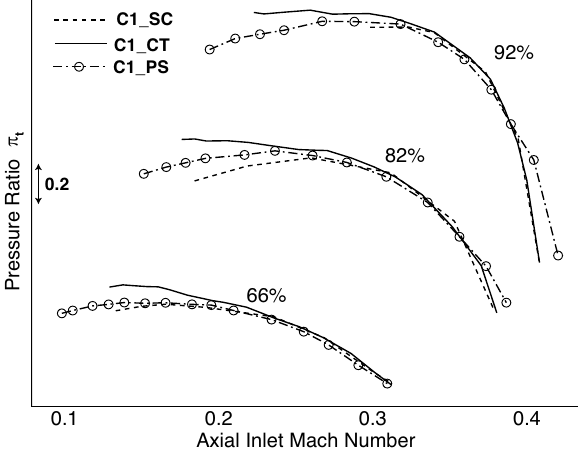
Figure 13. Experimental comparison of C1 compressor performance with smooth casing (SC), inducer bypass (PS) and casing treatment (CT).